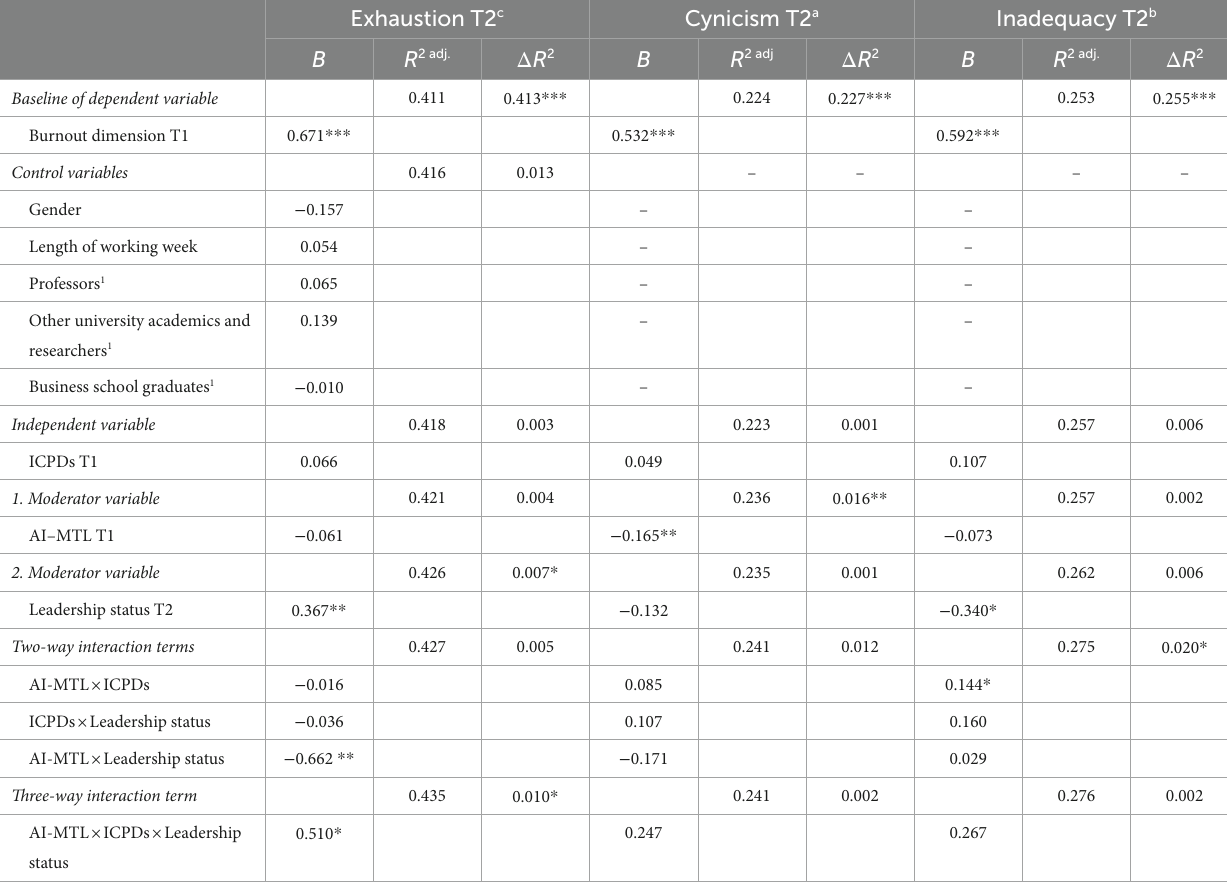
TABLE 3 The longitudinal associations between intensified career-related planning demands (ICPDs) and burnout (exhaustion, cynicism, and inadequacy) moderated by affective-identity motivation to lead (AI-MTL) and leadership